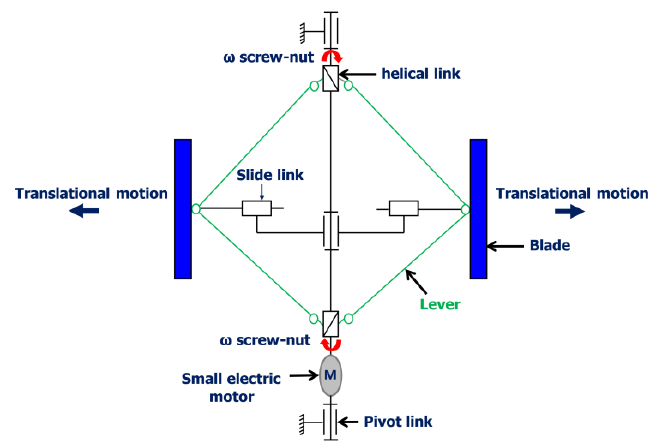
Figure 2. ( a ) 3D design of Floating Darrieus-type wind turbine with three-stage rotors ( b ) Schematic diagram details.